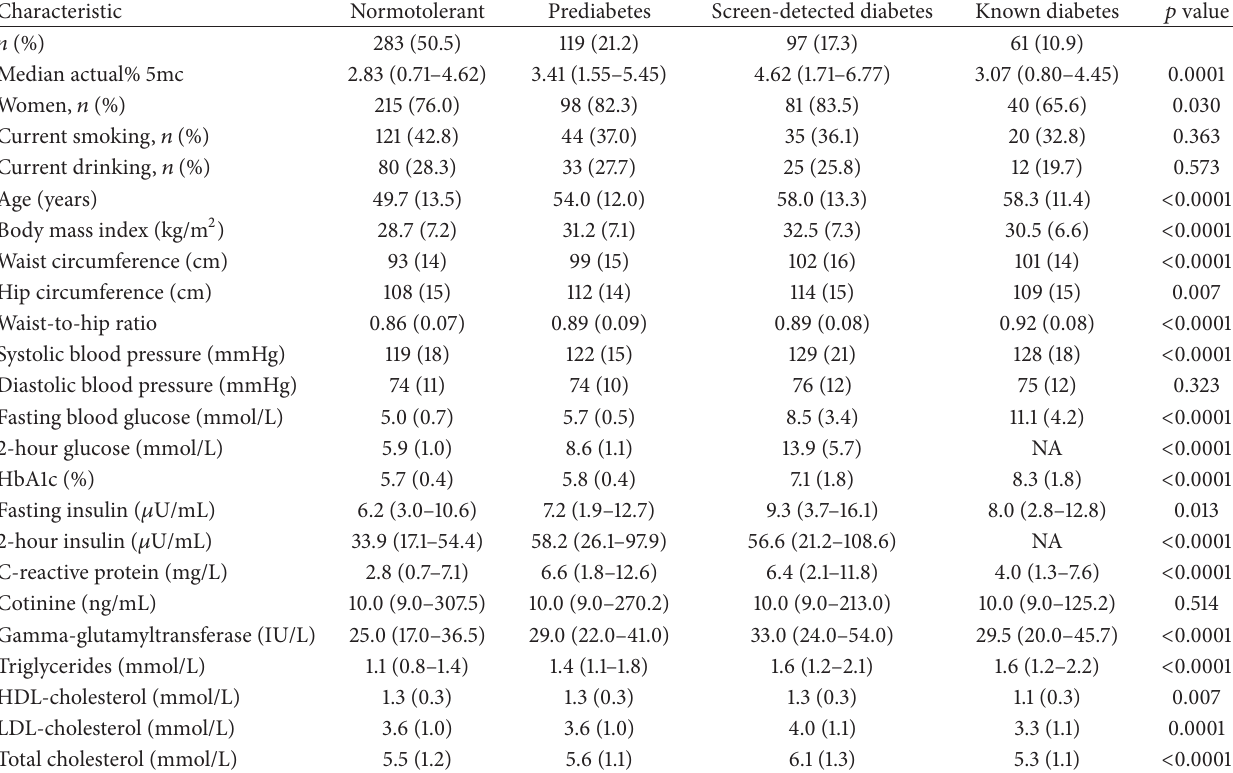
Table 1: Characteristics according to glucose tolerance